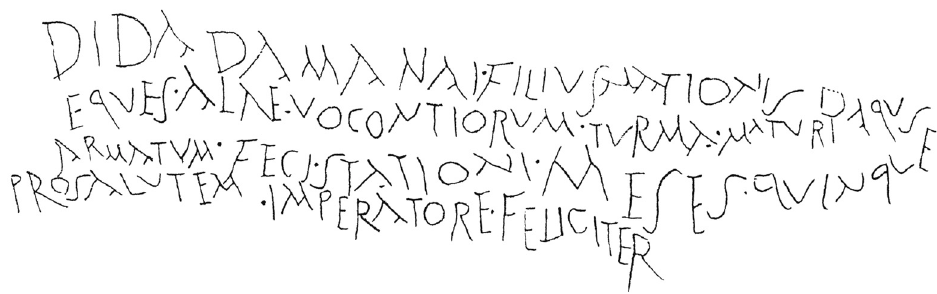
Figure 1. Tracing of the ‘Dida’ inscription at al-Muwayh by A. Bülow-Jacobsen©, dimensions: 3.09 m long, 0.60 m high, see AE 1996: 1647; Bülow-Jacobsen et al. (1995, p.